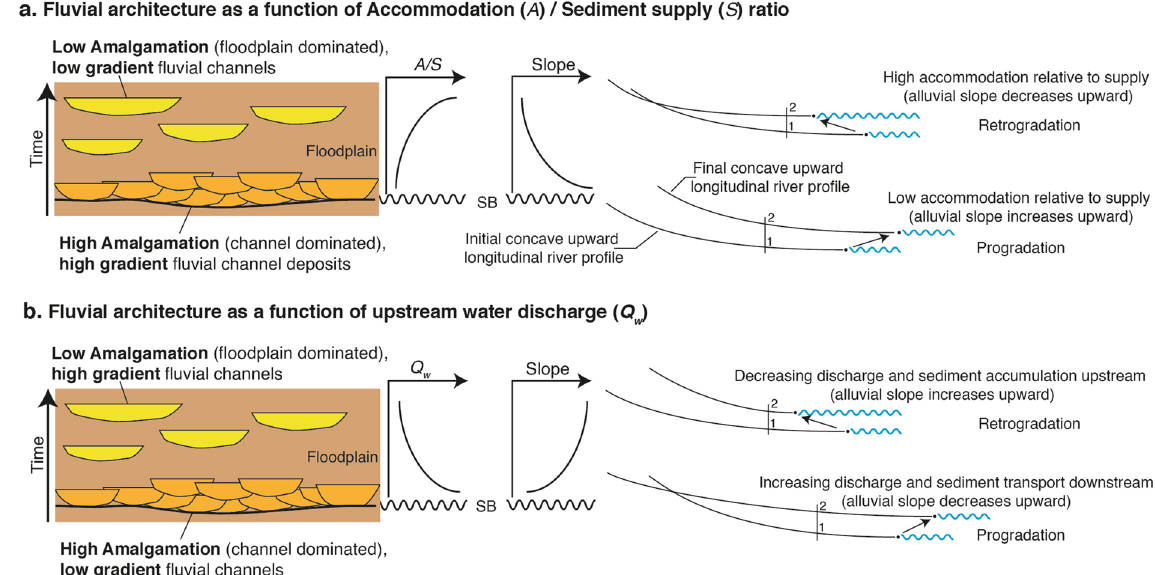
Figure 1. Conceptual figure explaining fluvial architecture as a function of the Accommodation ( A ) to Sediment supply ( S ) ratio and water discharge ( Q w ). ( a ) Low A/S results in the deposition of high gradient fluvial channels with a high degree of amalgamation and an overall progradation of the system. Under high A/S , low gradient fluvial channels with a low degree of amalgamation are deposited with an overall retrogradation of the system. Figure based on the ideas by e.g., 4,10 ( b ) As Q w increases, low gradient channels with a high degree of amalgamation are deposited with an overall progradation of the system while as Q w decreases, high gradient channels with a low degree of amalgamation are deposited with an overall retrogradation of the system. In this scenario, base level rise is constant and changes in fluvial architecture are solely driven by changes in Q w